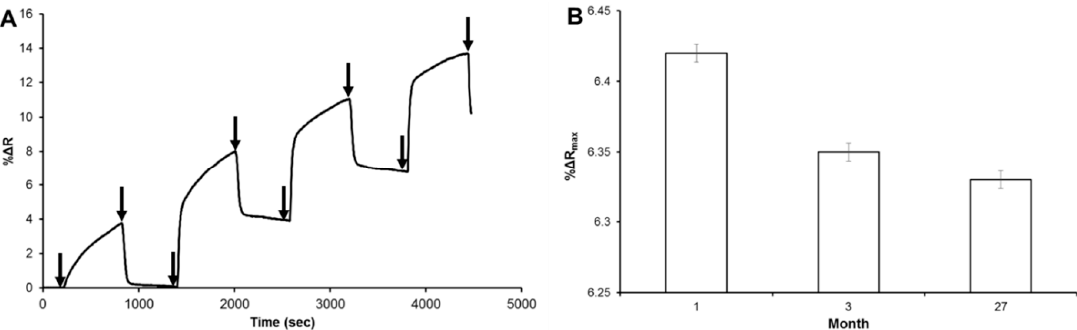
Figure 5. Reusability ( A ) and storage stability ( B ) of the molecularly imprinted nanofilm on-chip.